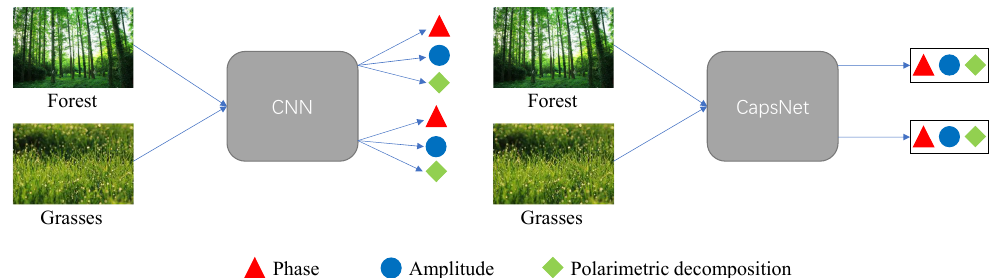
Figure 2. Illustration of the difference between classic CNN and